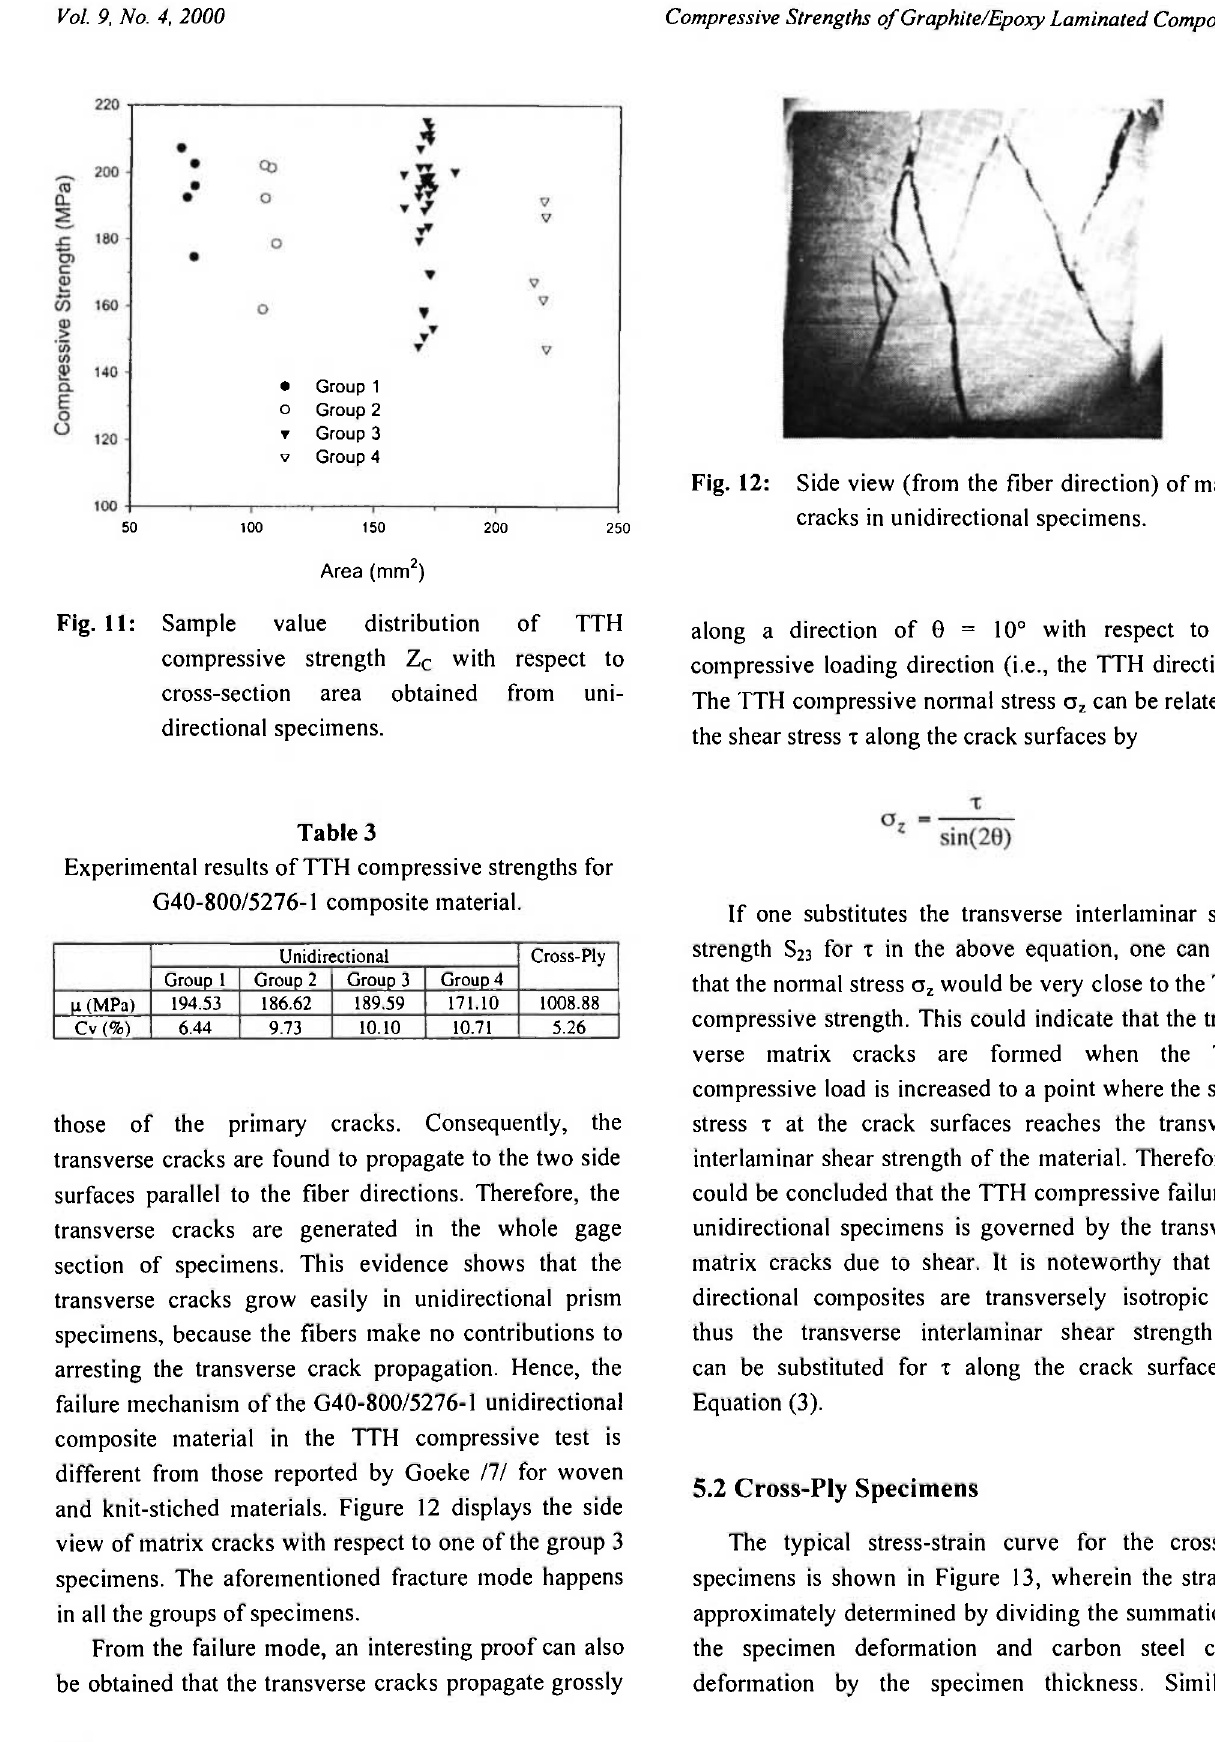
along a direction of θ = 10° with respect to the compressive loading direction (i.e., the TTH direction).